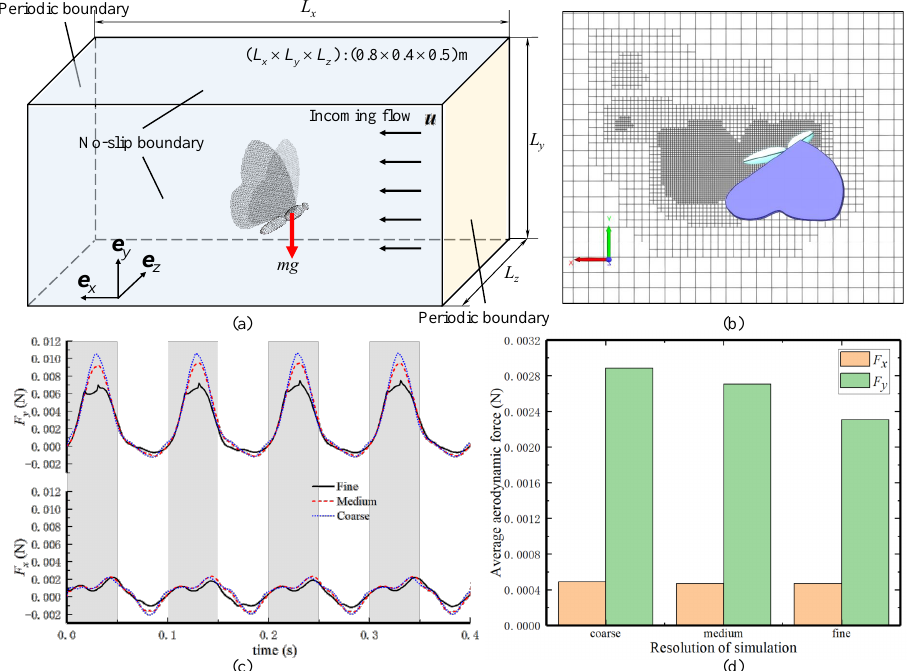
Figure 2. Computational fluid simulation set-up and resolution-independent study: ( a ) fluid computational domain for flight simulation of the butterfly multi-body model; ( b ) domain structure with lattice mesh on the middle symmetry plane of the butterfly; ( c ) the aerodynamic forces of the butterfly under three-resolution set-ups ( F x , horizontal force; F y , vertical force); and ( d ) the average aerodynamic forces under three-resolution